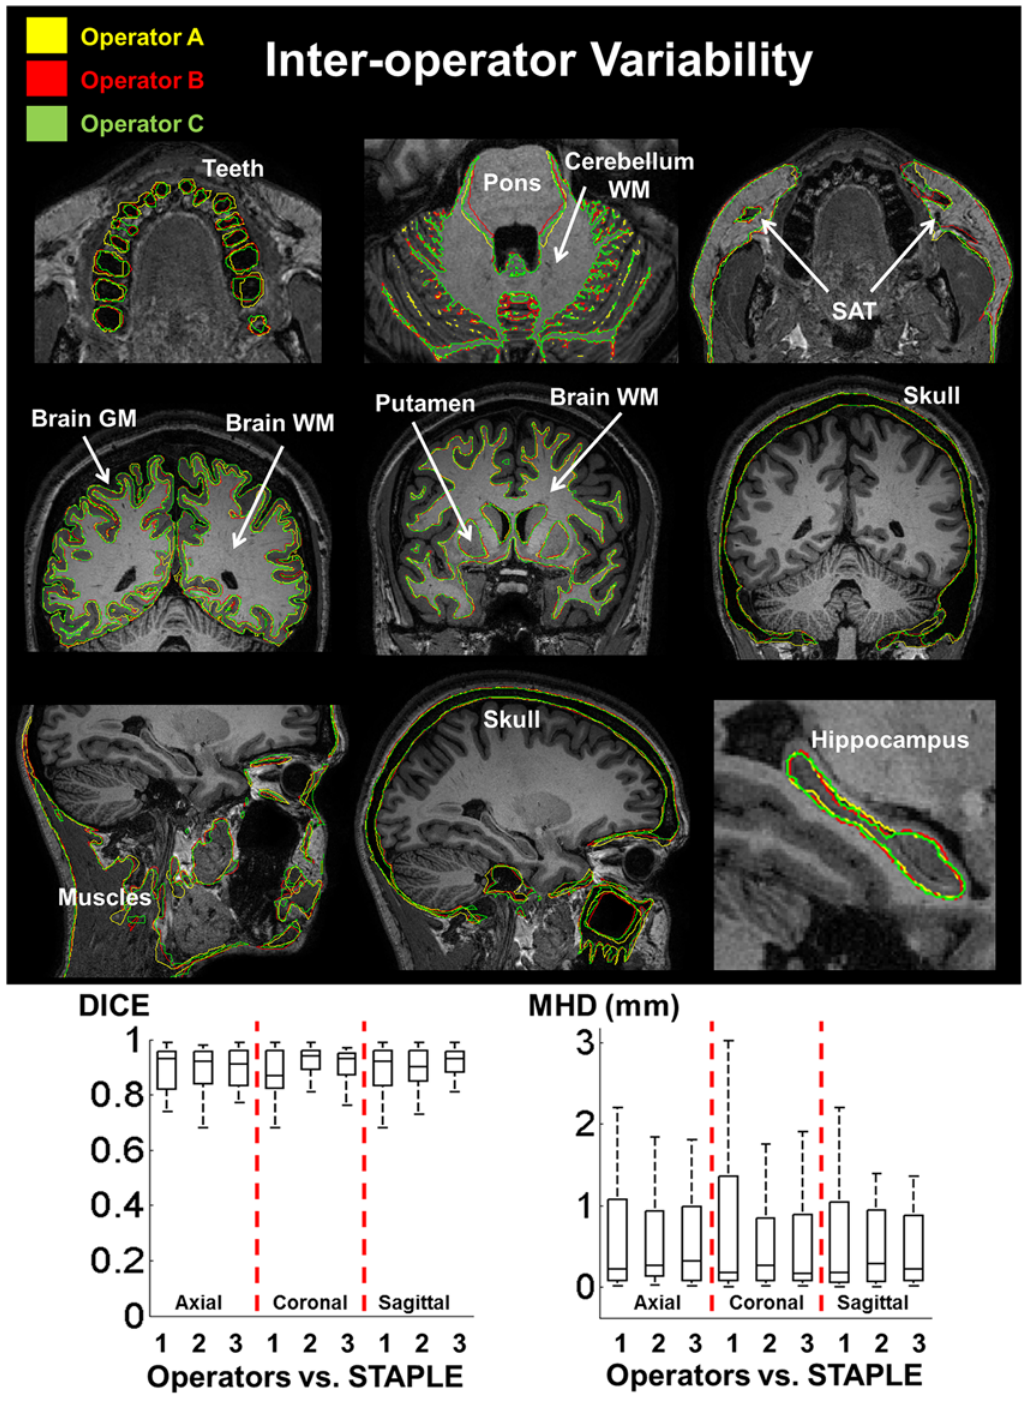
Fig 7. Inter-operator variability. Examples of segmentation variability among operators A (yellow), B (red), and C (green) for a few representative structures of the head. (Bottom) Box plots of the values of the Dice ( D ) and modified Hausdorff distance ( MHD ) for the 35 structures are included in the analysis. The variability was assessed by comparing the segmentations of the operators with a consensus ground truth obtained using the STAPLE algorithm.